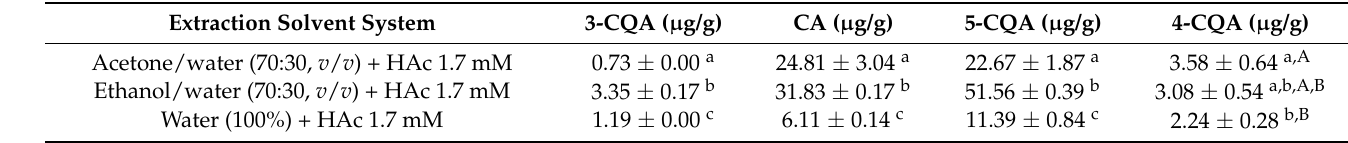
Table 3. Comparison of the phenolic acid content in fresh sprout samples treated with three different extraction solvents. Results are expressed as mean value ± standard deviation ( n = 3).